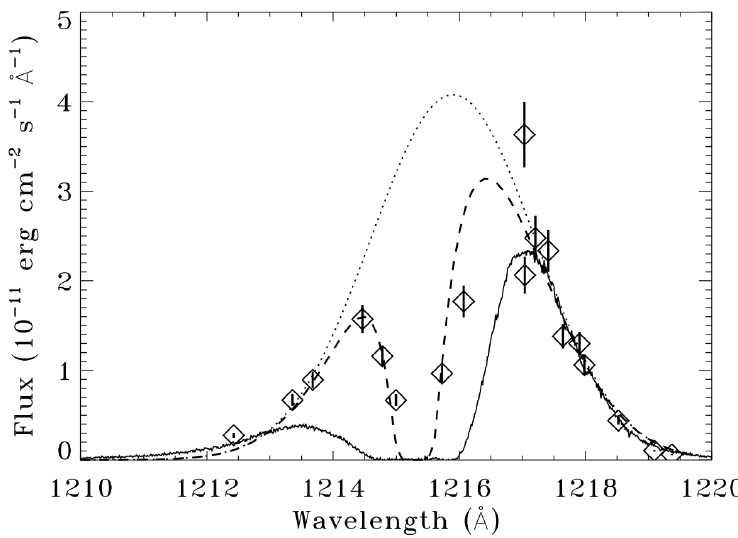
Figure 9. Example of a Ly α reconstruction based on H 2 fluxes. Diamonds indicate the wavelengths at which measured H 2 progressions are pumped, the dashed line indicates an H 2 model for T = 2500K and log N ( H 2 ) = 18.5 and a surface filling factor for the H 2 material, as seen by the Ly α emitting region. In this model, the intrinsic Ly α line is Gaussian-shaped (dotted), the H 2 gas sees the dashed profile, and the Ly α profile observed by HST is subject to additional interstellar absorption (solid line). From Herczeg et al. [80]. c AAS. Reproduced with (cid:13)